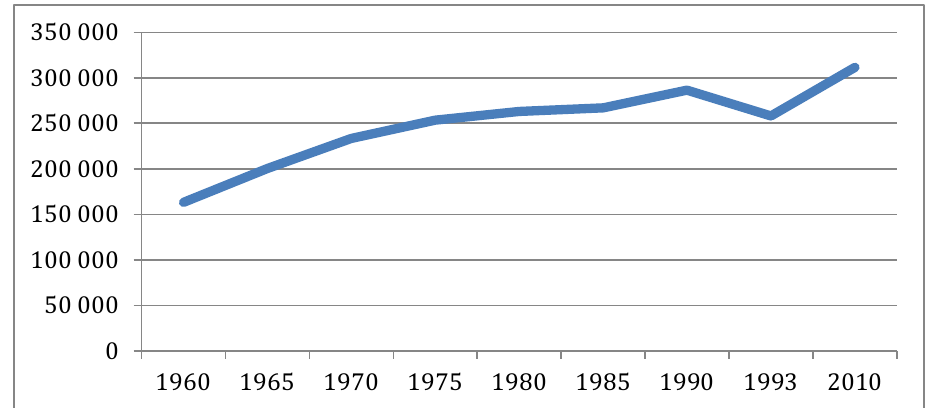
Figure 4 . Engineers working in Sweden, 1960–2010. Adapted from Statistics Sweden, the Education Register and Labour Statistics Based on Administrative